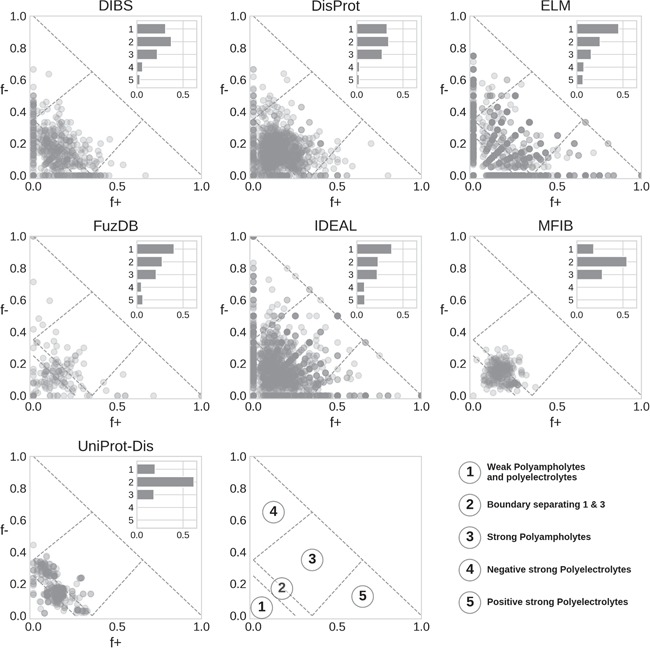
Das and Pappu classification of IDRs. Each marker represents a region, with the main Das and Pappu class numbers shown. The histogram is normalized by the total number of region in each database.